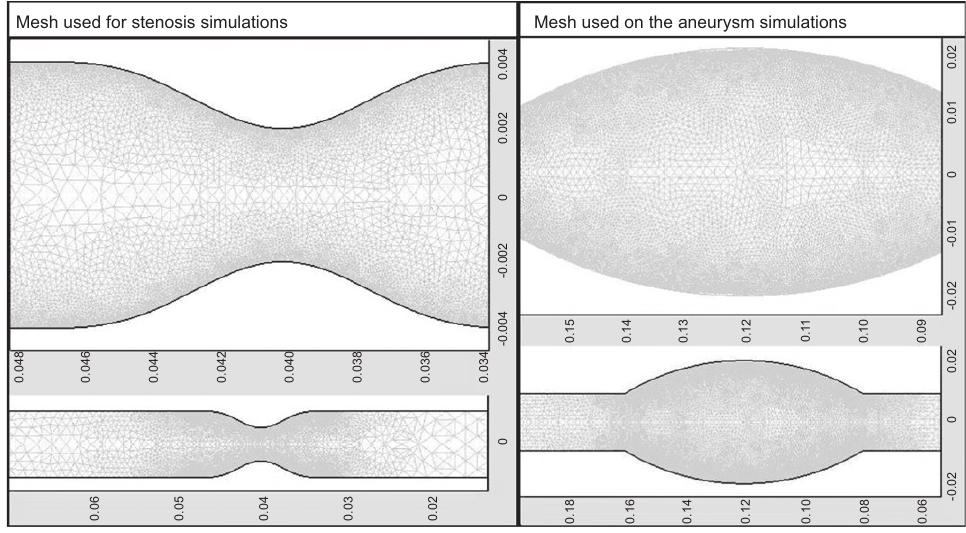
Figure 1 3D grid for stenosis and